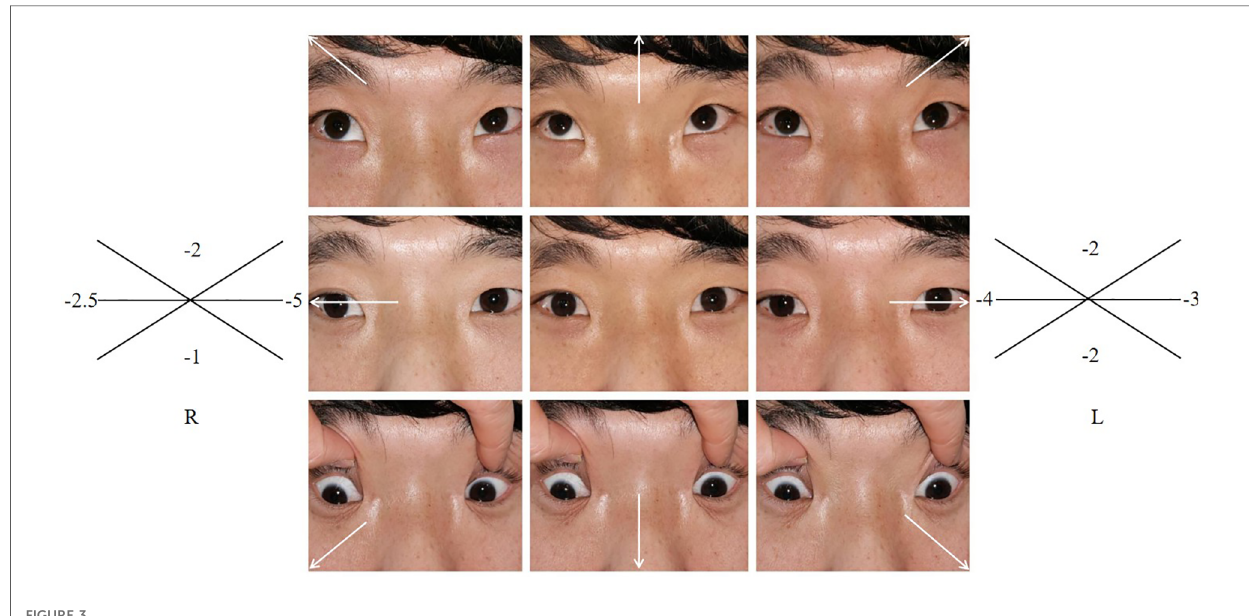
FIGURE 3 Eyeballs